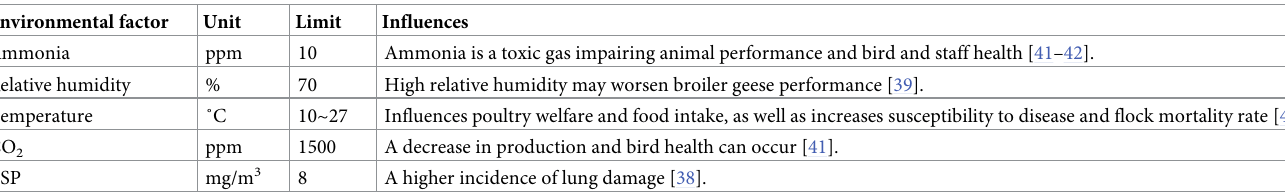
Table 1. The selected environmental parameters for PI